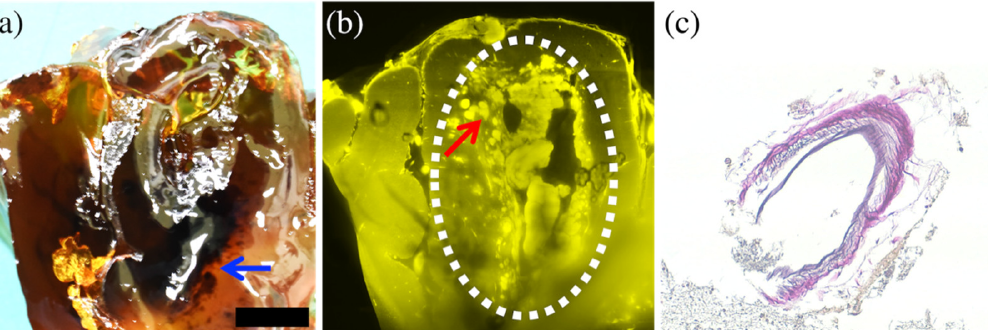
Figure 6. Comparison of macroscopic and the cross-sectional CUBIC image with histopathological image in case 6. The macroscopic image after CUBIC processing ( a ) showed an internal black hem- orrhage (arrow) through the transparent brain parenchyma. The cross-sectional CUBIC image ( b ) showed the contusion of the cerebral cortex containing the subcortical hematoma (dotted circle). An inadequately clarified hematoma interfered with the CUBIC imaging of the ruptured artery, but there was a small torn artery at the margins of the hematoma (( b ), arrow), which was detected in the histopathological (Elastica van Gieson staining) image ( c ). The bar (on the lower right side of ( a )) is equal to 10 mm for ( a , b ) and 100 μ m for ( c ).